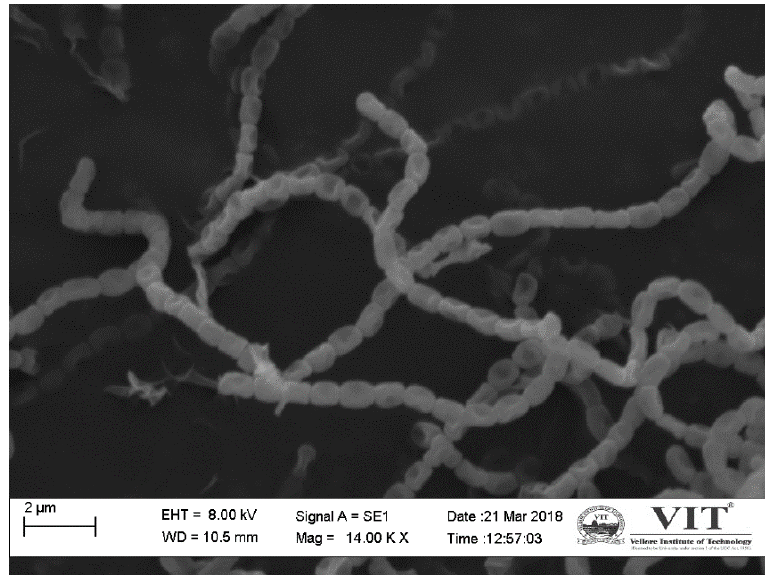
Figure 1. Image of strain VITAKN on scanning electron microscopy.